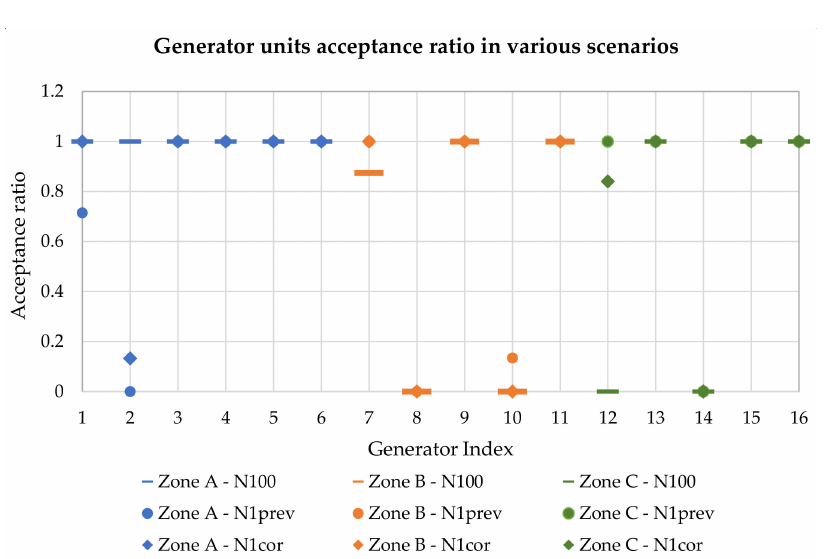
Figure 6. Acceptance ratio of generators in the three analyzed